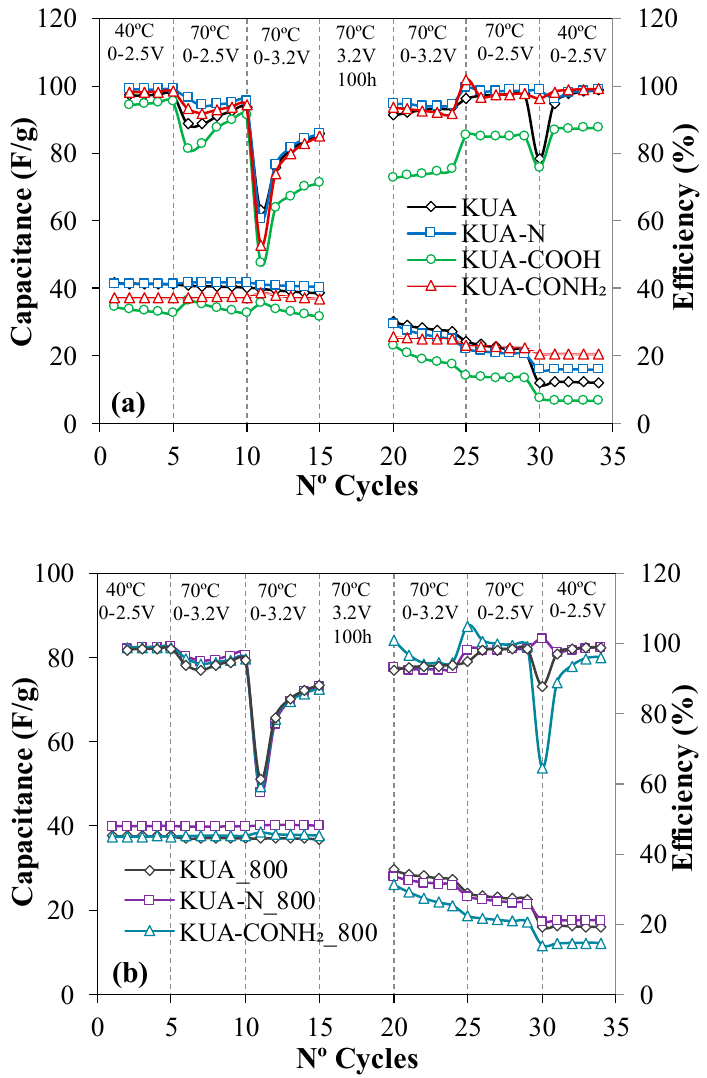
Figure7. Evolutionofcapacitanceandcoulombice ffi ciencyduringthedurabilitytestforselectedEDLCs: Figure 7. Evolution of capacitance and coulombic efficiency during the durability test for selected ( a ) KUA, KUA-N, KUA-COOH and KUA-CONH 2 ; ( b ) KUA_800, KUA-N_800 and KUA-CONH 2 _800. EDLCs: (a) KUA, KUA-N, KUA-COOH and KUA-CONH 2 ; (b) KUA_800, KUA-N_800 and KUA- 1M TEMABF 4 / PC. j = 40 mA / CONH 2 _800. 1M TEMABF 4 /PC. j = 40 mA/g.